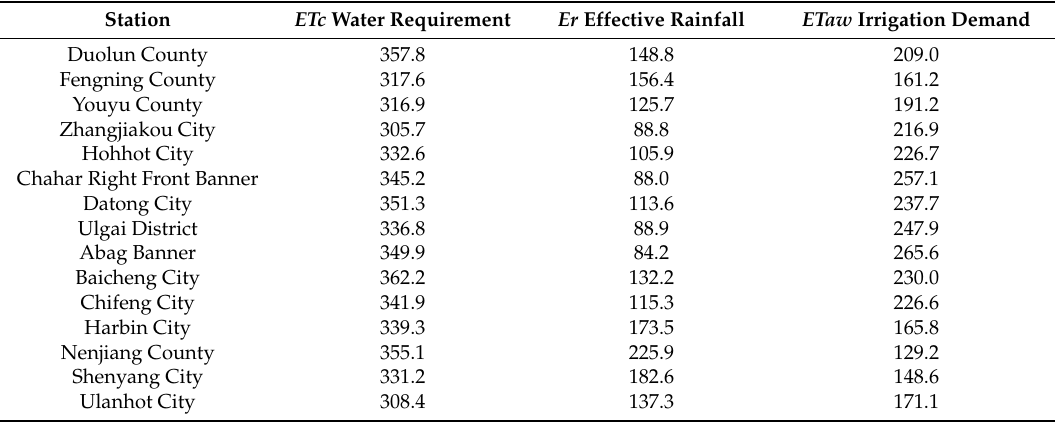
Table 2. Spatial variation in oat water requirements at 15 stations (mm).